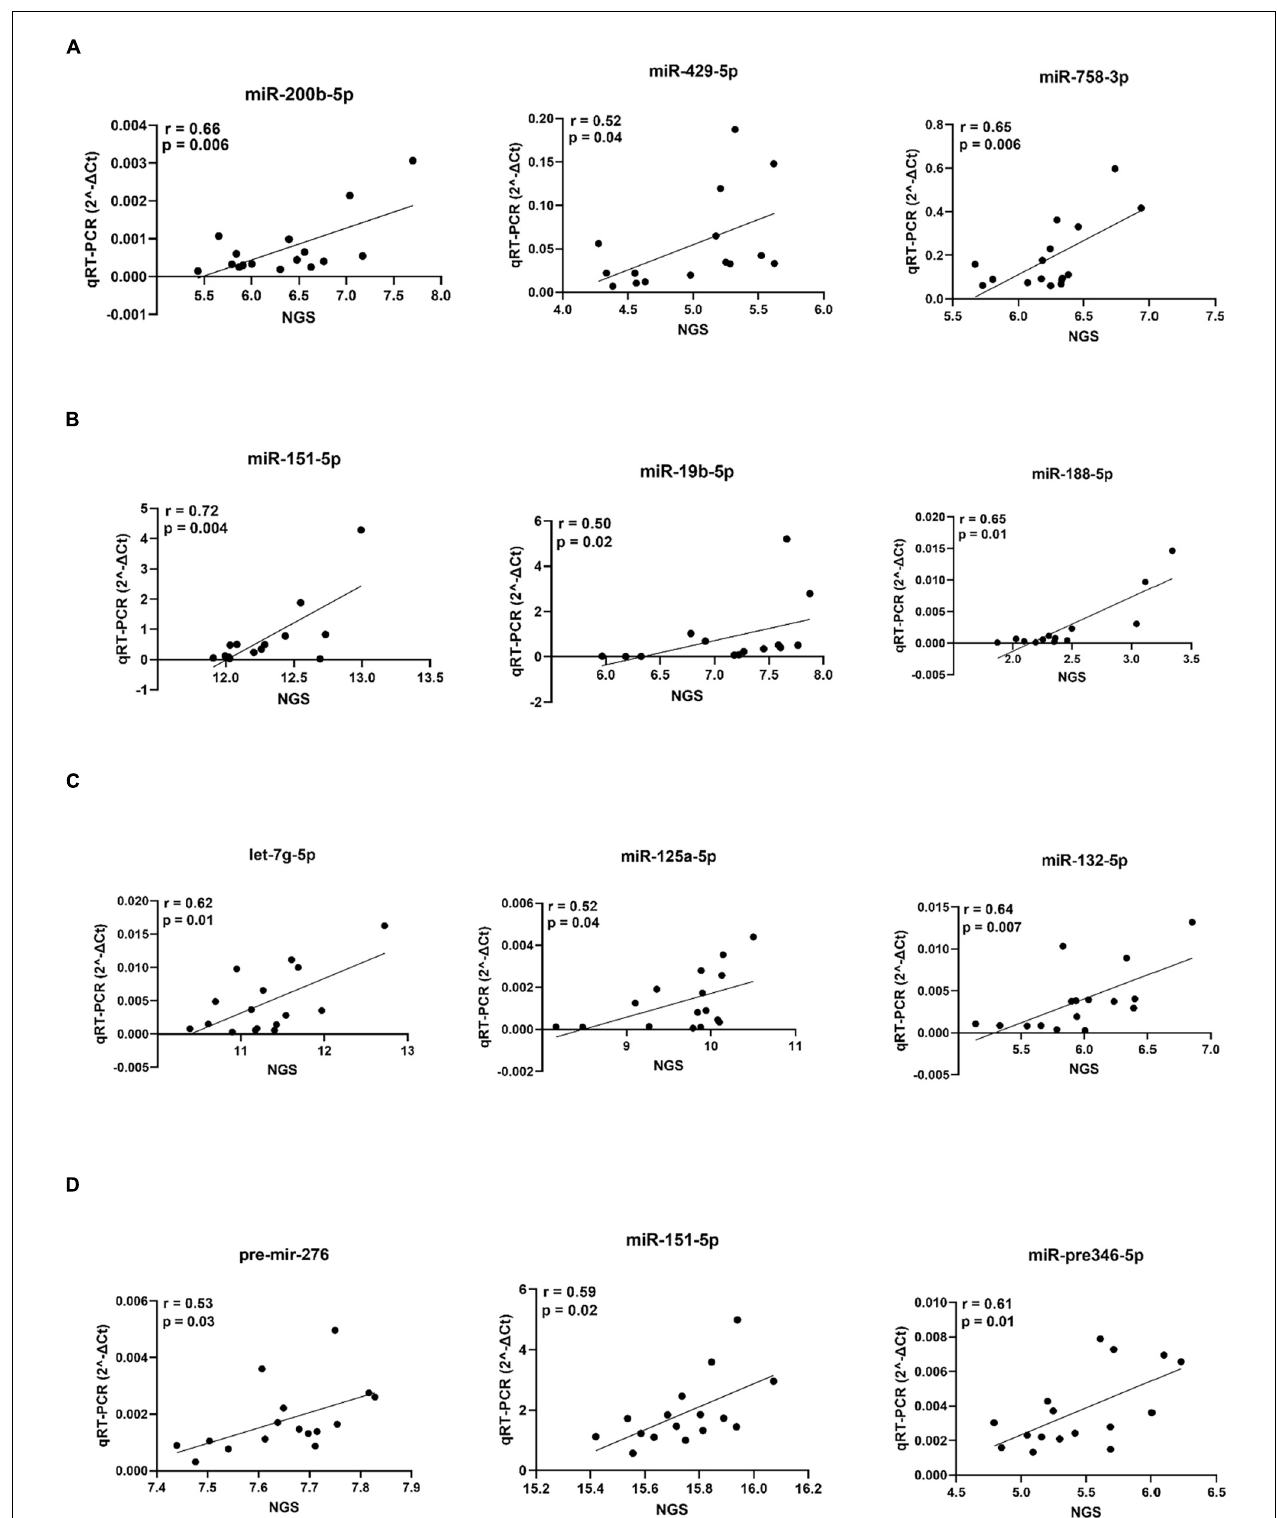
FIGURE 12 | qPCR validation of selected miRNAs of the adrenal gland (A) , amygdala (B) , hippocampus (C) and hypothalamus (D) . For each miRNA, variance stabilized transformed NGS signals are plotted on the x -axis and qPCR (2ˆ– (cid:49) Ct) data on the y -axis.